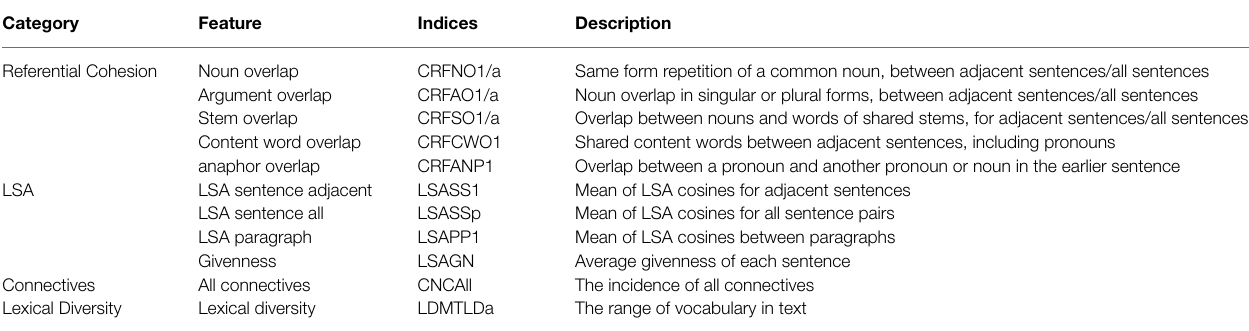
TABLE 1 | Cohesion measures and corresponding indices (adapted from McNamara et al., 2014).